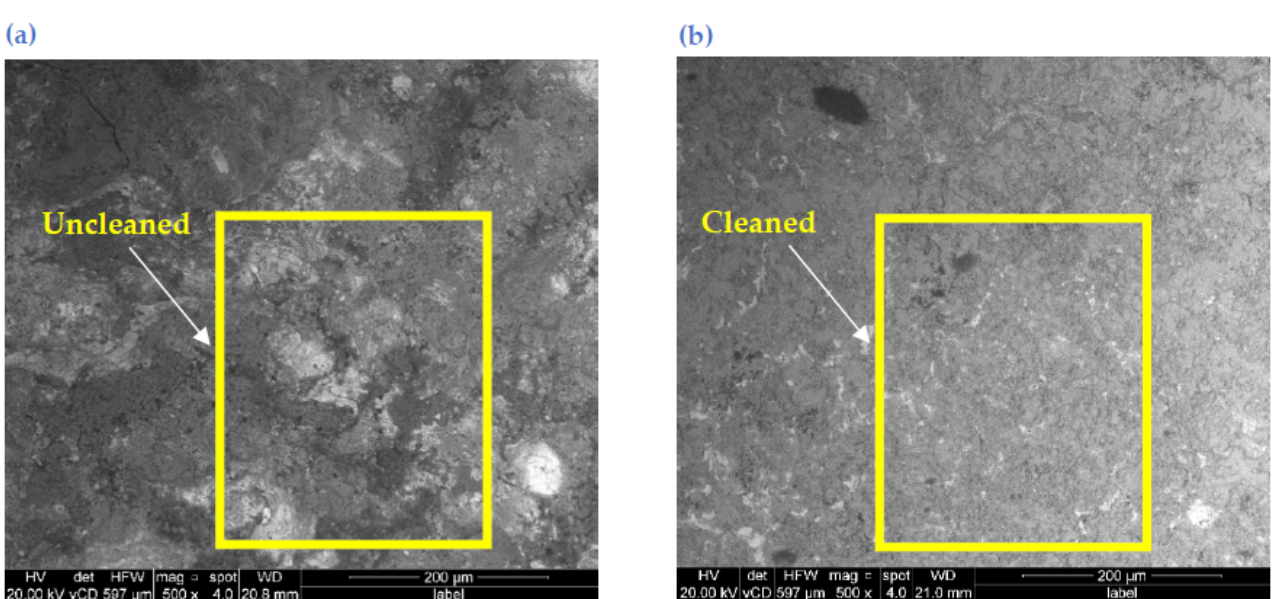
Figure 12. SEM image of sample D ( a ) before and ( b ) after cleaning at 500× magnification.